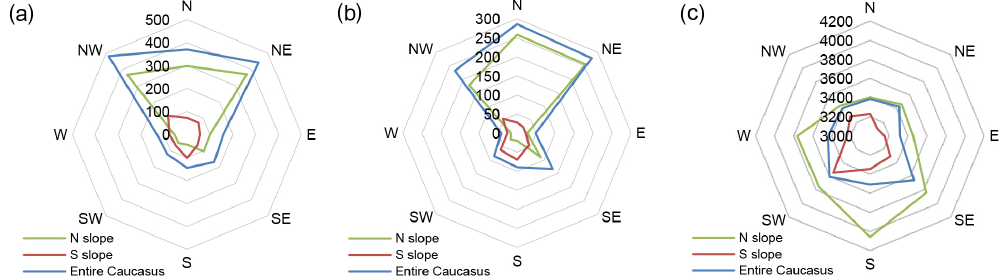
Figure 8. Proportion of glacier aspect by (a) number, (b) area (km 2 ) and (c) aspect vs. mean elevation (a.s.l.).